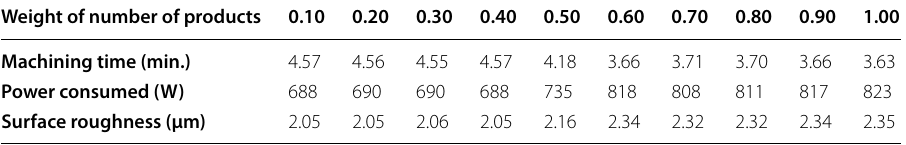
experimental data and Fig. 4b for the checked portion of experimental data. In Fig. 4, the normalized shuffled values of PMS output parameters are plotted in Y -axis for the num-